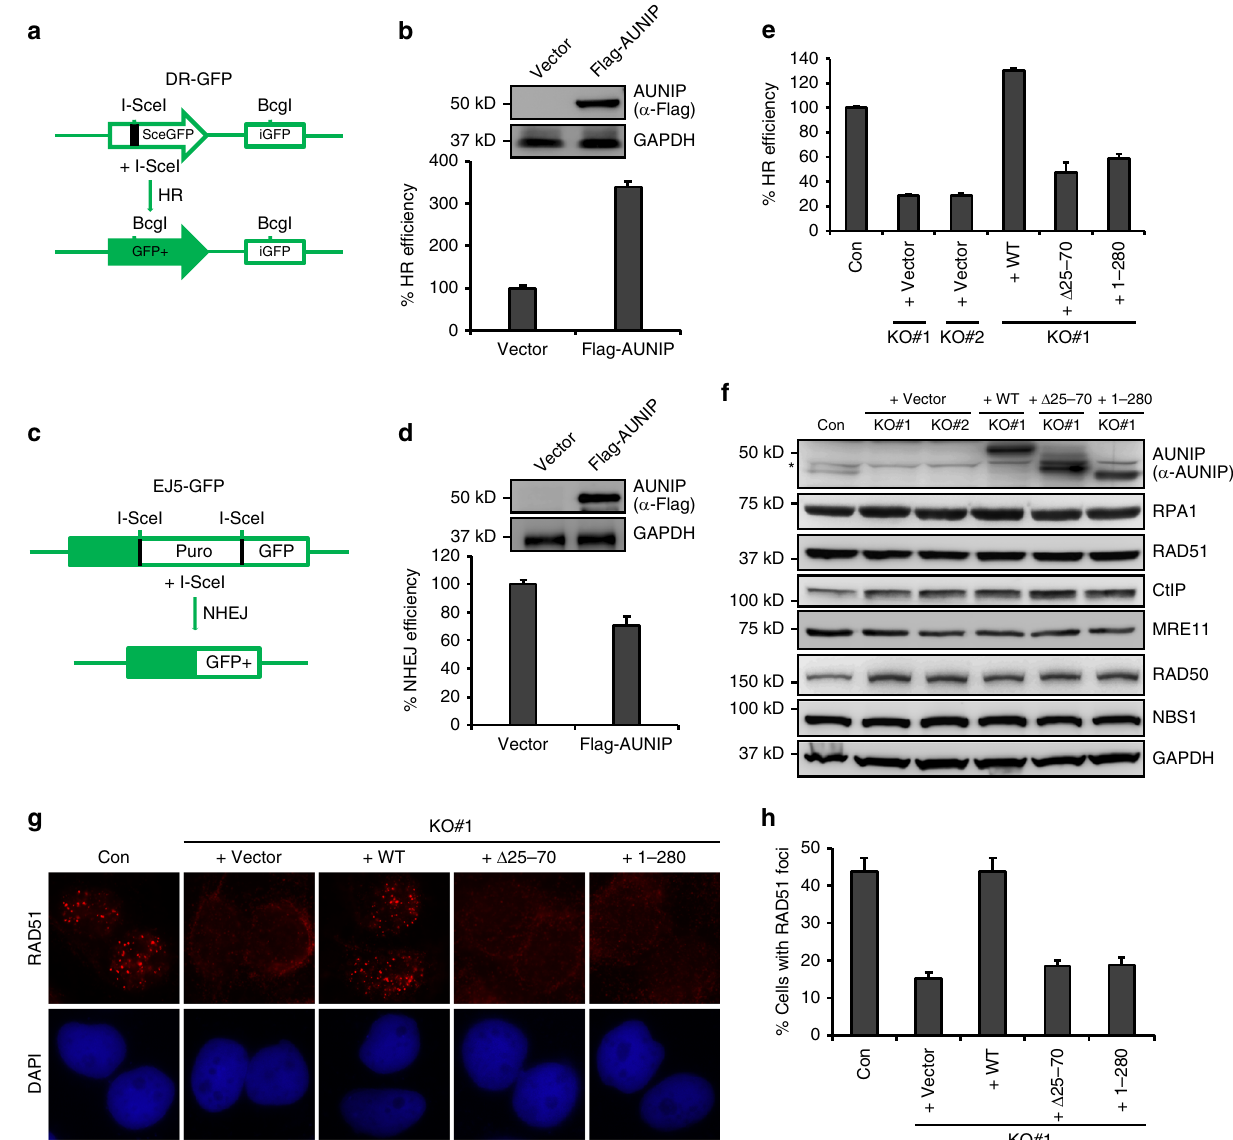
Fig. 3 AUNIP promotes HR and inhibits NHEJ. a Schematic illustration of the GFP-based HR reporter assay. b AUNIP overexpression promotes HR. U2OS DR-GFP cells stably expressing Flag-tagged AUNIP were electroporated with pCBASce construct and were assayed for HR ef fi ciency by monitoring GFP positivity 48 h post electroporation. Data represent mean ± SEM from three independent experiments. c Schematic illustration of the GFP-based NHEJ reporter assay. d AUNIP overexpression inhibits NHEJ. U2OS EJ5-GFP cells stably expressing Flag-tagged AUNIP were electroporated with pCBASce construct and were assayed for NHEJ ef fi ciency by monitoring GFP positivity 48 h post electroporation. Data represent mean ± SEM from three independent experiments. e AUNIP knockout impairs HR. AUNIP-de fi cient U2OS DR-GFP cells stably expressing an empty vector (Vector), Flag-tagged wild-type AUNIP, the Δ 25 – 70 mutant, or the 1 – 280 mutant were electroporated with pCBASce construct for 48 h before they were assayed for HR ef fi ciency. Data represent mean ± SEM from three independent experiments. f The overall levels of a panel of key HR proteins are not markedly affected by AUNIP silencing. Whole-cell lysates from indicated cells were subjected to western blot analysis using indicated antibodies. Asterisks indicate nonspeci fi c bands. g , h Knockout of AUNIP impairs CPT-induced RAD51 foci formation. AUNIP-de fi cient cells stably expressing an empty vector (Vector), Flag-tagged wild-type AUNIP, the Δ 25 – 70 mutant, or the 1 – 280 mutant were treated with 1 μ M CPT for 6 h before being processed for RAD51 immuno fl uorescence. Representative RAD51 foci are shown in g . Data represent mean ± SEM from three independent experiments ( h ) These results suggest that AUNIP promotes HR and inhibits lines that harbor a chromosomally-integrated copy of the DR- NHEJ. GFP 44 or EJ5-GFP 45 reporter to measure the repair rates of I- SceI-induced DSBs in chromosomal DNA by HR or NHEJ, To verify and extend the above fi ndings, we took advantage of respectively (Fig. 3a, c). We fi rst stably overexpressed AUNIP in the CRISPR/Cas9 gene-editing approach to inactivate AUNIP these reporter cell lines and measured the ef fi ciency of DSB gene expression in the U2OS DR-GFP cell line. We con fi rmed the repair. As shown in Fig. 3b, overexpression of AUNIP led to a absence of AUNIP in this cell line by Western blotting analysis dramatic increase in the frequency of HR. Conversely, over- (Supplementary Fig. 3a). Consistent with the notion that expression of AUNIP substantially inhibited NHEJ (Fig. 3d). overexpression of AUNIP promotes HR and inhibits NHEJ, NATURE COMMUNICATIONS | 8: